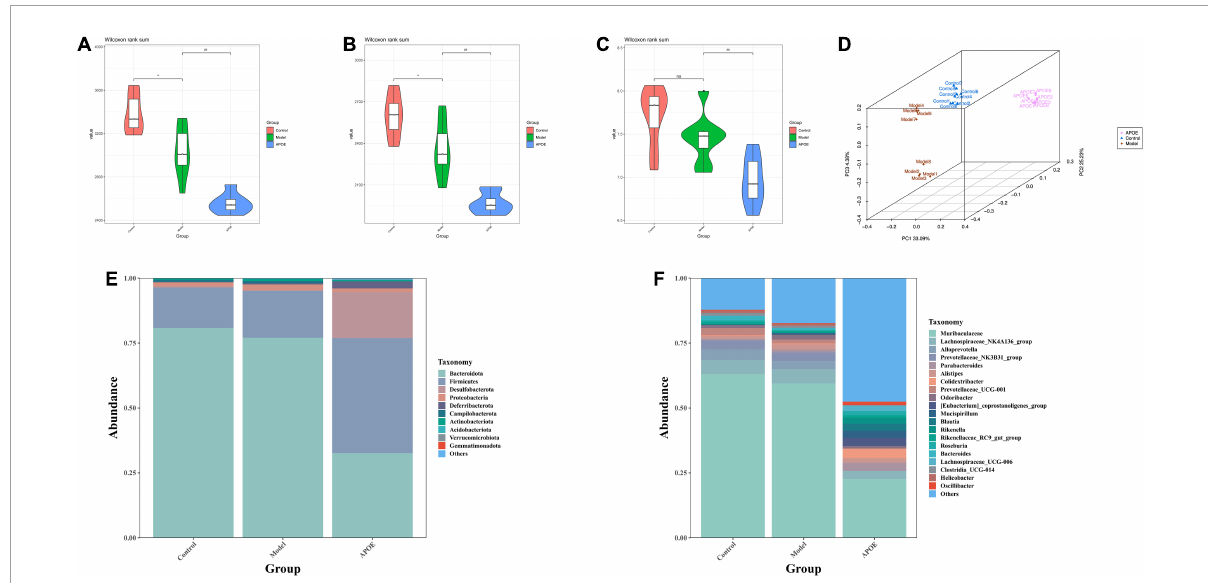
FIGURE4 Deletion of ApoE affects the gut microbial composition of aging mice. (A) Chao 1 index, n = 8. (B) Observed species index, n = 8. (C) Shannon index, n = 8. (D) PCoA analysis. (E) Relative abundance of gut microbiota (phylum level). (F) Relative abundance of gut microbiota (genus level). * P < 0.05 vs. Control group, ## p < 0.01 vs. Model